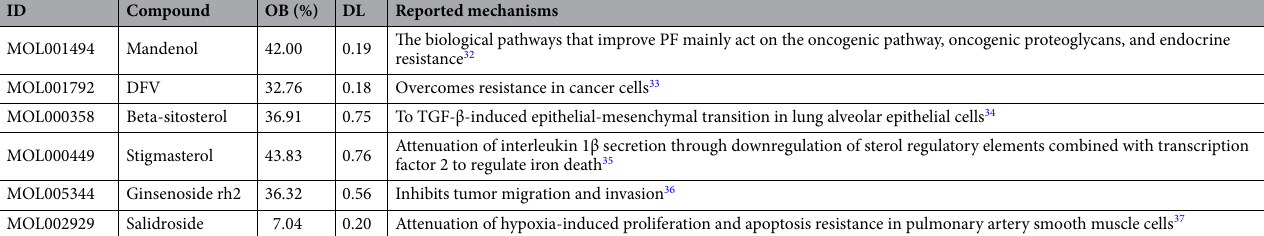
Table 1. Properties and potential mechanisms of active compounds in QLT to